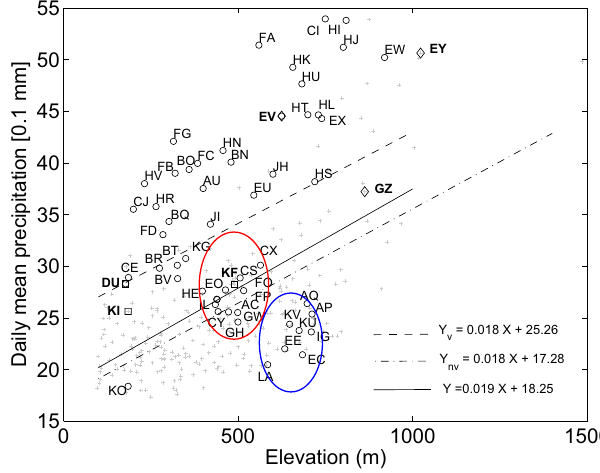
Fig. 8. Scatter plot of mean daily precipitation vs. elevation for BW Fig.8. Scatterplotofmeandailyprecipitationvs. elevationforBW(circlesindicatevalleystations,andcrosses (circles indicate valley stations, and crosses indicate non-valley sta- indicatenon-valleystations).